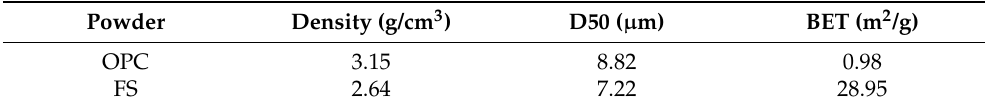
Table 1. Density, median particle diameter, and specific surface area of cement and flash-calcined sediment.